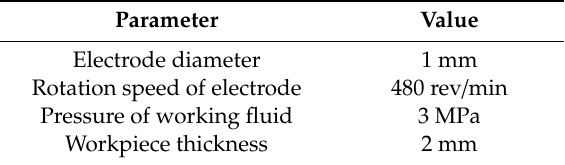
Table 1. Parameters of flow field simulation for di ff erent tool electrode conditions.